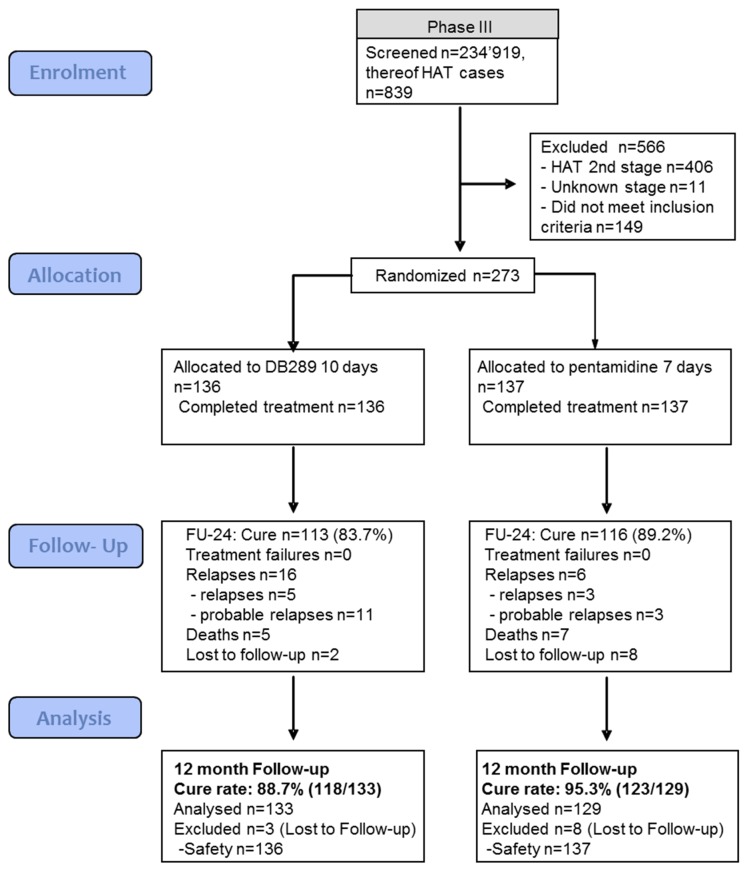
Pafuramidine (DB289) Phase 3 study CONSORT flowchart.